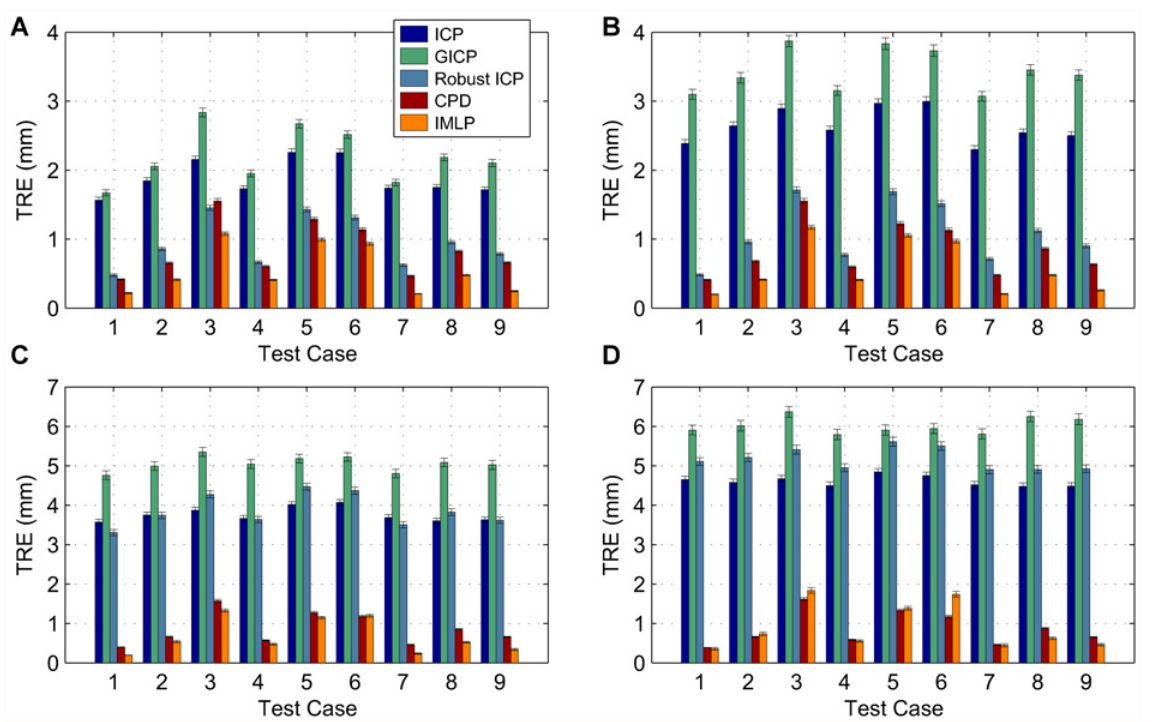
Fig 6. Registration errors for registering a source shape containing outliers to a point-cloud target under moderate misalignment. (Experiment 5A). Source shapes were randomly generated from a mesh model of a human hip (Fig. 1A), misaligned by [15, 30] mm / degrees, and registered back to a point-cloud representation of the mesh. The test cases represent different noise models used to generate noise on the source shape (Table 4). Outliers were added to the source shape constituting (A): 5%, (B): 10%, (C): 20%, and (D): 30% of the source points. For each test case, 300 randomized trials were conducted, with successful registrations being used to compute an average target registration error (TRE). The error bars provide approximate standard deviations of the reported average TRE values. The proposed IMLP algorithm was evaluated relative to standard ICP [1], GICP [11], a robust variant of ICP [4], and CPD